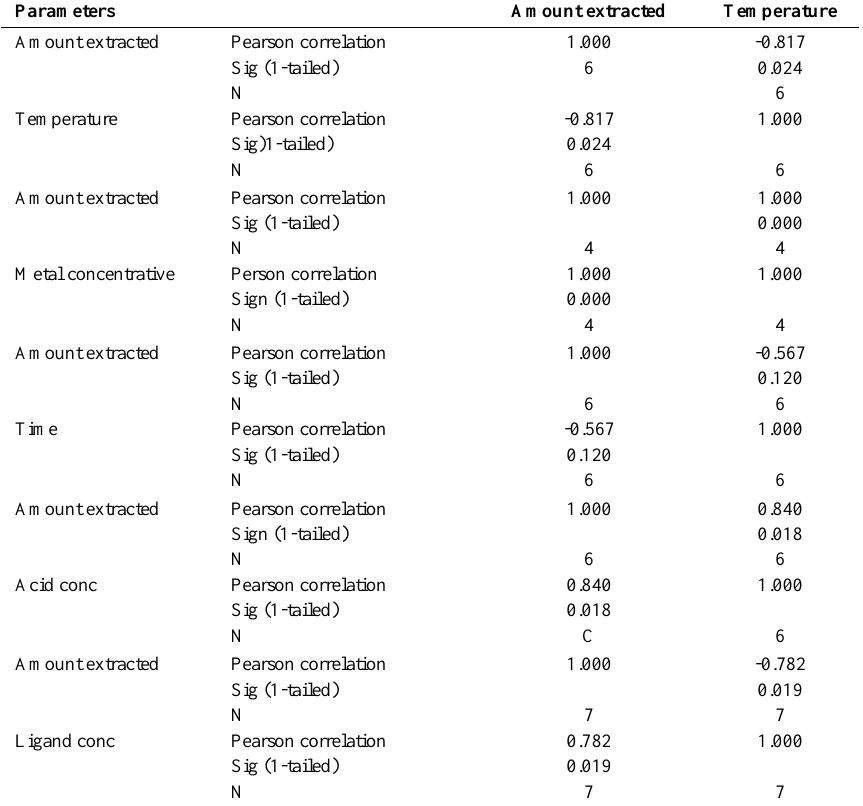
Table 9. Result of Pearson correlation for extraction of Fe(III) H 2 SAL complex Parameters Amount